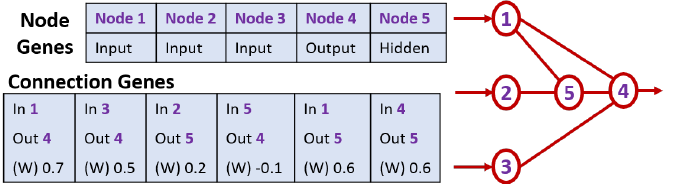
Figure 2: A typical genome or network created in NEAT. ( W ) denotes the weight assigned to each connection.